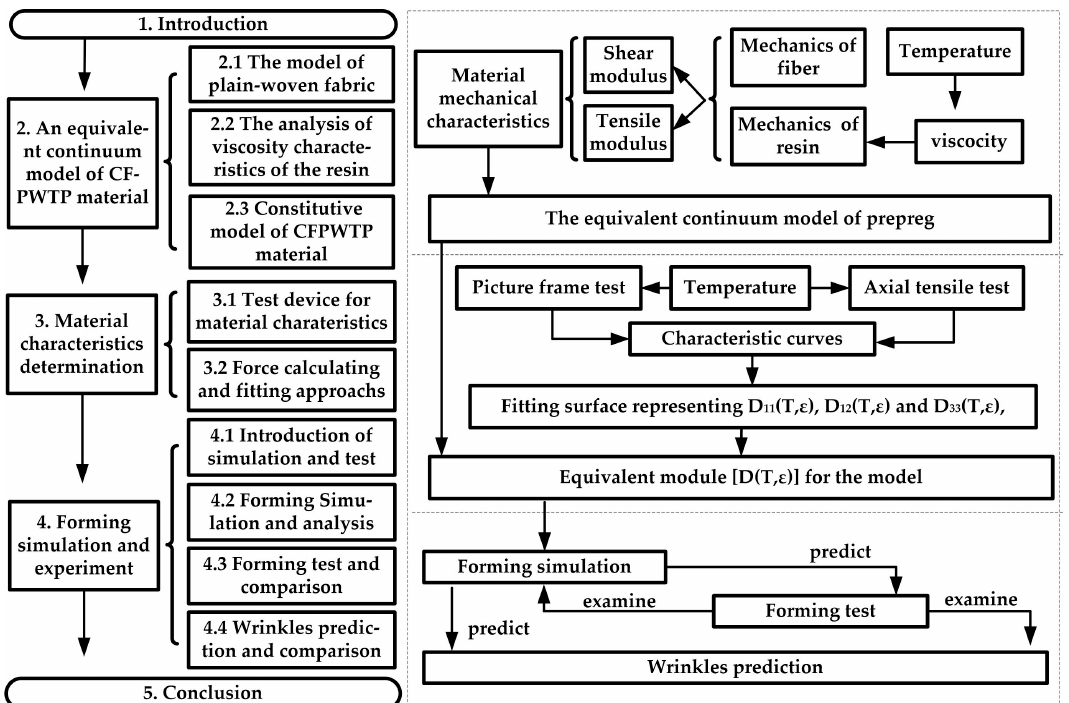
Figure 1. The architecture of the paper includes the model construction and validation approaches.